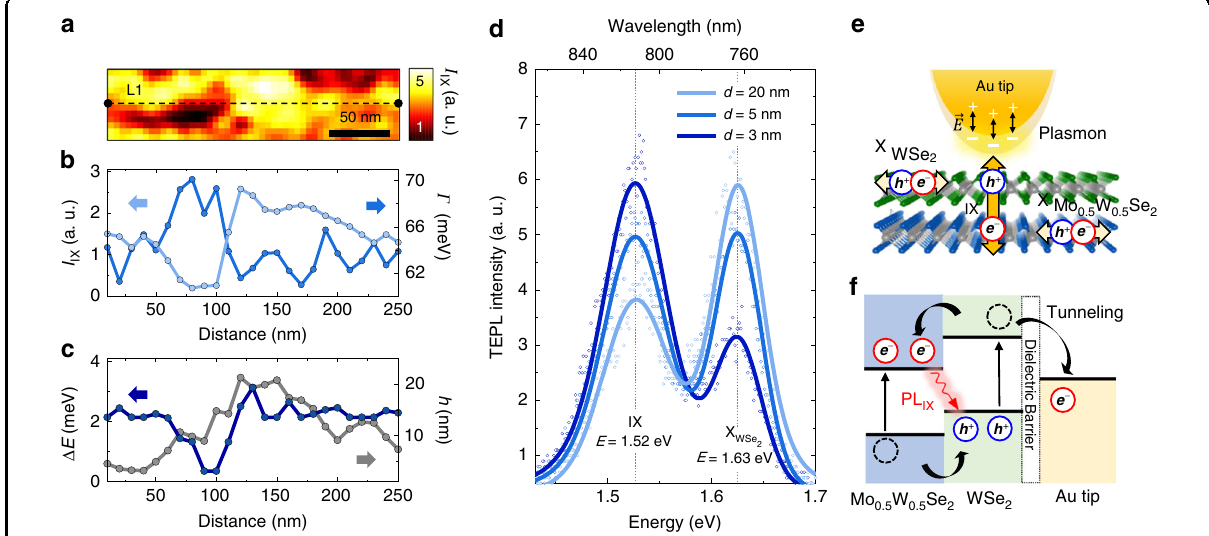
Fig. 2 Nanoscale heterogeneity of the interlayer coupling strength and TEPL of IX and X WSe . a Hyperspectral TEPL image of the heterobilayer 2 exhibiting inhomogeneous IX emission with 20 nm spatial resolution. b – c Spectroscopic and topographic line pro fi les for the dashed line L1 in (a). Nanoscale spatial heterogeneities in TEPL peak intensity I IX , linewidth Γ , peak energy shift Δ E , and topographic height ℎ are revealed far beyond the diffraction limit. d Evolving TEPL spectra of the heterobilayer as a function of the tip-sample distance d . The PL responses of IX ( E = 1.52 eV) and WSe 2 ( E = 1.63 eV) are acquired with the tip located in the weak interlayer coupling region. e Illustration for the more ef fi cient plasmon-IX (out-of-plane dipole) coupling compared to the plasmon-X (in-plane dipole) coupling when the Au tip closely approaches to the crystal. f Illustration for the type-II band alignment of a